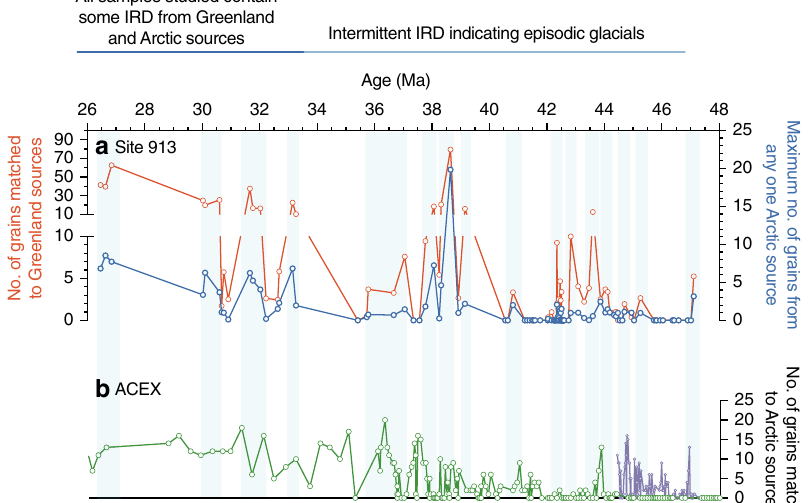
Fig. 3 Greenland and circum-Arctic sources of ice-rafted debris from 48 – 26 Ma delivered to Site 913 in the Greenland Sea and the ACEX site in the central Arctic Ocean. Vertical blue lines indicate intervals with signi fi cant numbers of grains matched to a source at Site 913. a At Site 913, the number of grains matched to sources on Greenland (red line) and to Arctic sources (blue line). Vertical blue bars mark intervals with samples containing IRD. b Published ACEX data 37 reported using ages calculated using one published age model 69 (green line) that indicate an Arctic sea ice history corroborated by our results, after factoring in differences in resolution and errors in age models for both sites. Purple line shows the same data but with sample ages calculated using a second age model 68 . The Supplementary Information discusses the published ACEX age models in more detail. The Eocene- – Oligocene boundary